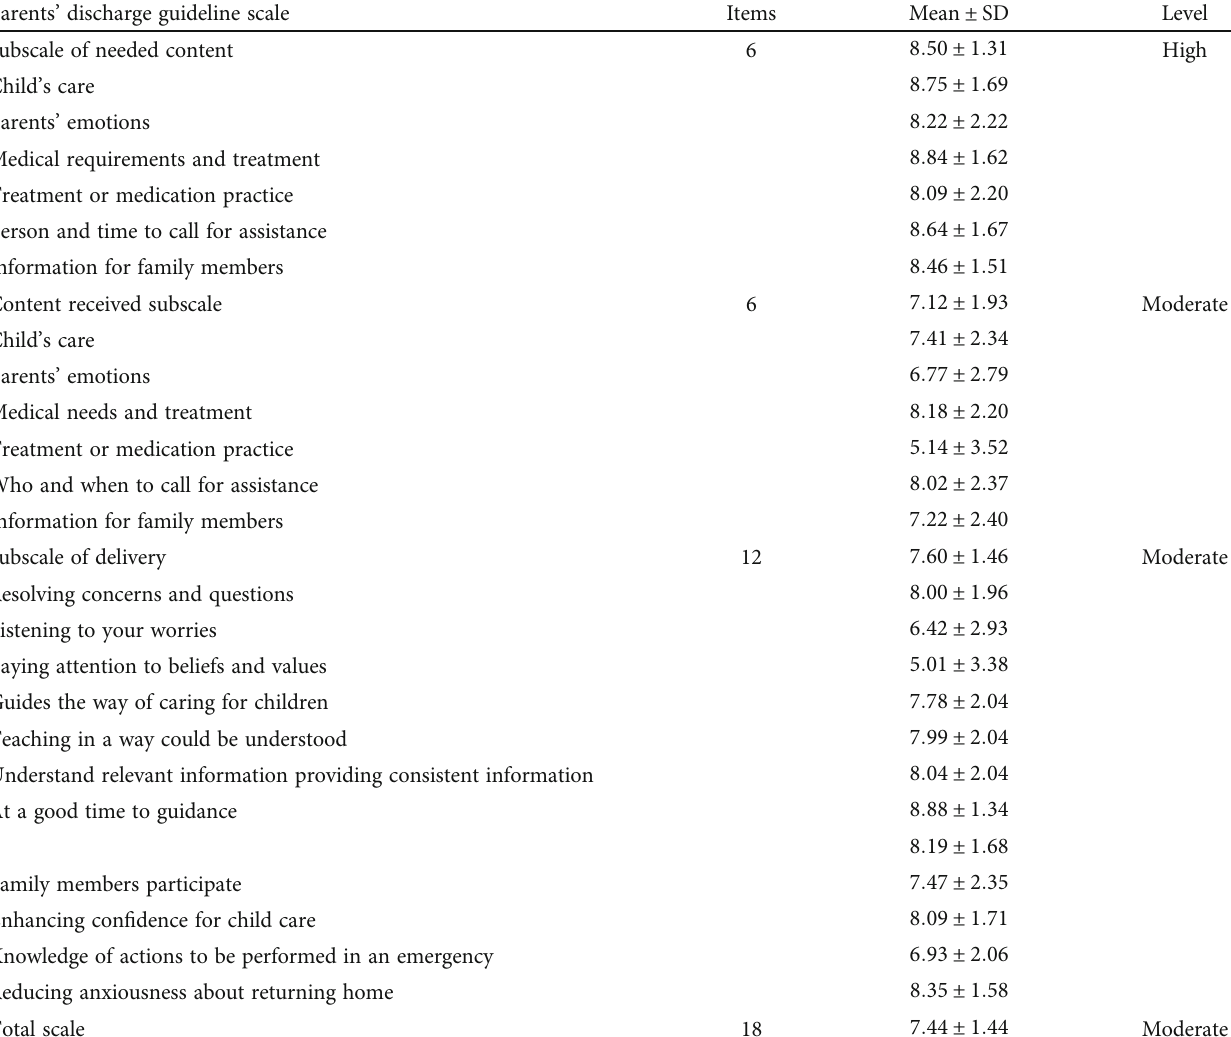
Table 3: Premature infants ’ parents ’ perception of parents of towards the discharge guidelines quality ( N = 208 ).